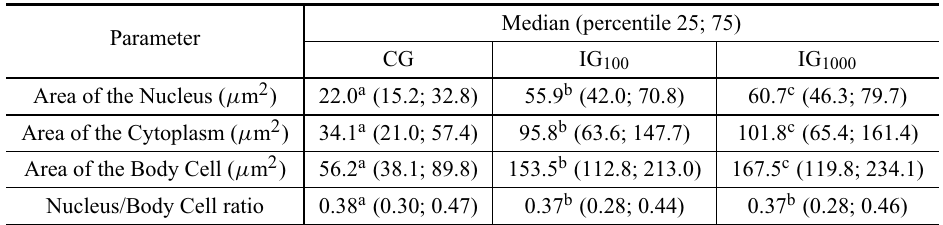
Median of the area of the nucleus, cytoplasm and body cell of the myenteric neurons in the colon of Swiss male mice infected by T. cruzi Y strain with 100 (IG 100 ) and 1000 (IG 1000 ) forms of trypomastigotes and the non-infected controls.